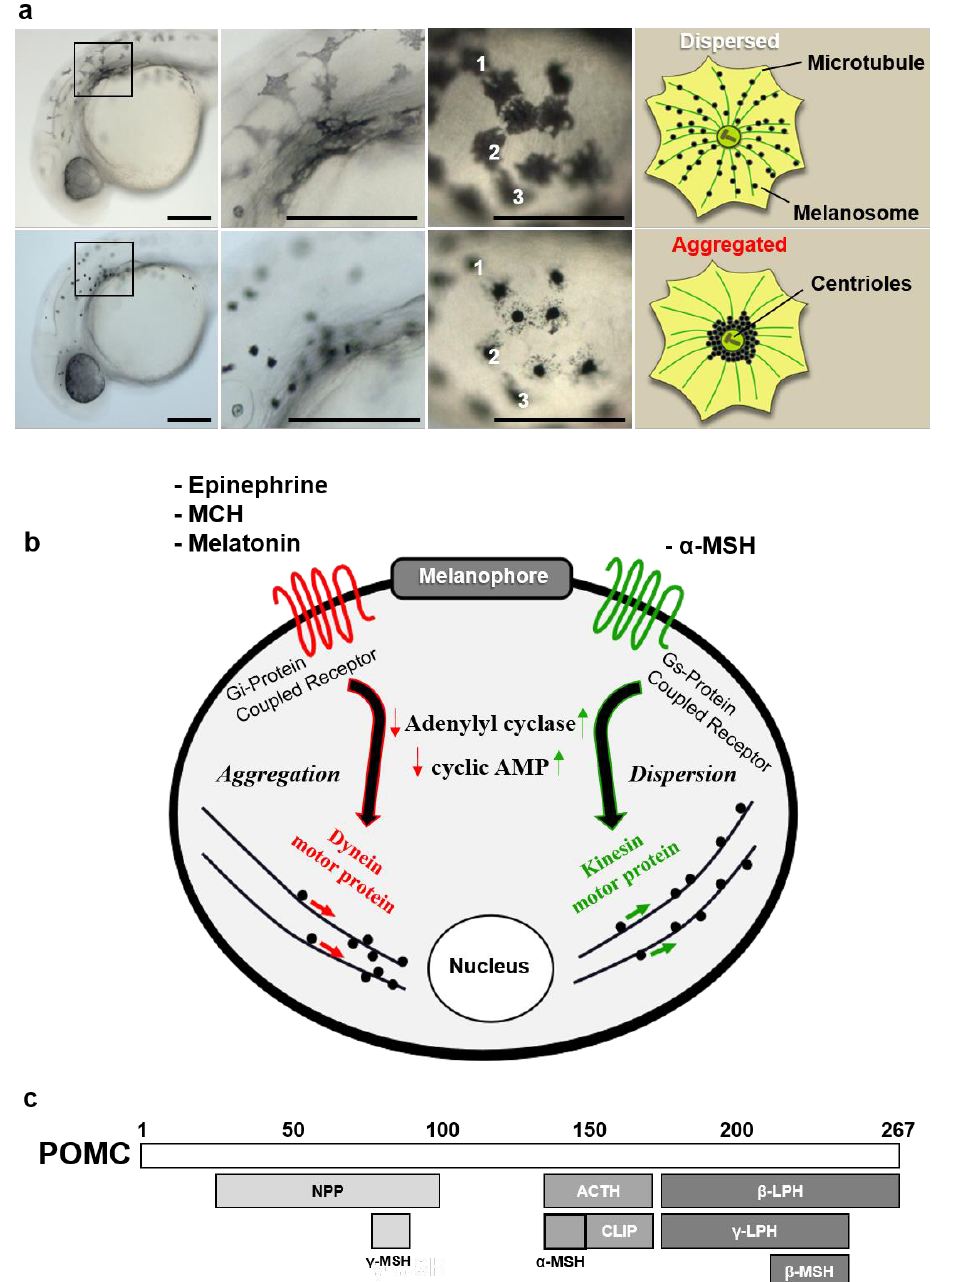
Figure 1. Characteristic features of zebrafish melanophore physiology. ( a ) High-resolution magnification of larval melanophores before and after treatment with the aggregating agent. Numbers (1, 2, 3) indicate individual melanophores two minutes after melatonin treatment. Schematic describes movement of melanosomes during aggregation process. Scale bars: 100 µ m. ( b ) Diagram of melanophore pigment cell showing major intracellular events following receptor-ligand binding of aggregating/dispersive agents. ( c ) Schematic showing POMC gene product and derivative molecules gener- ated by post-translational processing. Abbreviations: mch: melanin-concentrating hormone, npp: N -terminal peptide of proopiomelanocortin, clip: corticotropin-like intermediate peptide, lph: